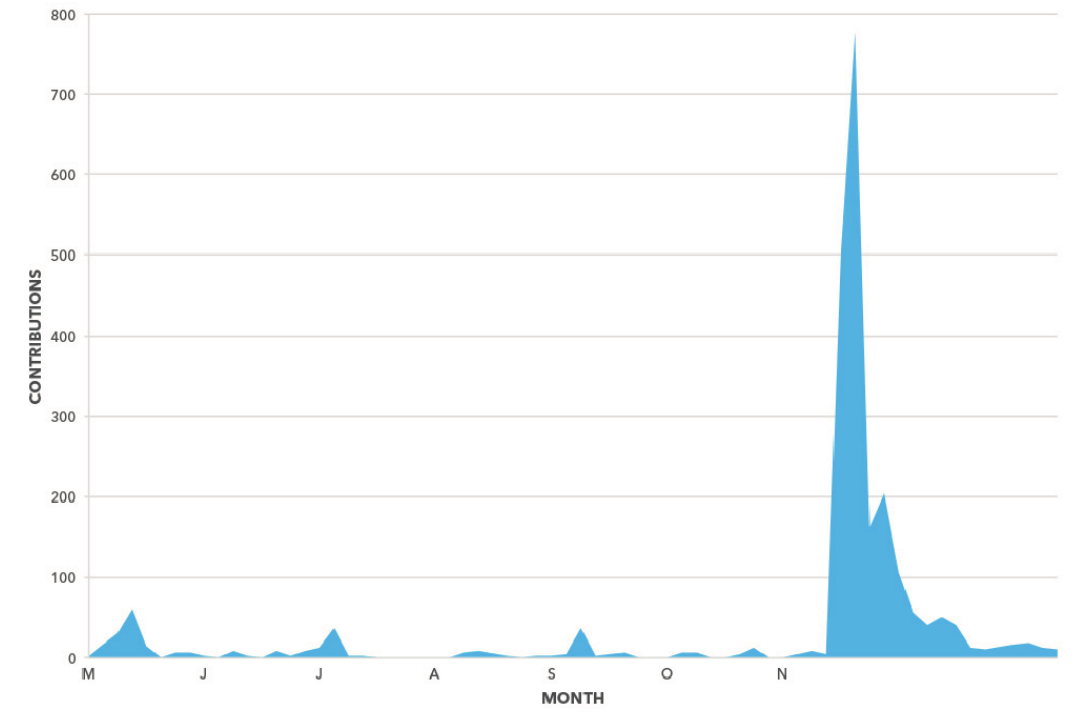
Figure 5. The number of volunteer contributions received from May–November 2013. The large spike in contributions during November coincides with the HEAT project winning the 2013 MIT Climate CoLab